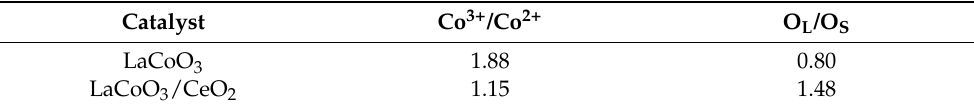
Table 2. Ratio of Co 3+ and Co 2+ and O L and O S of LaCoO 3 and LaCoO 3 /CeO 2.